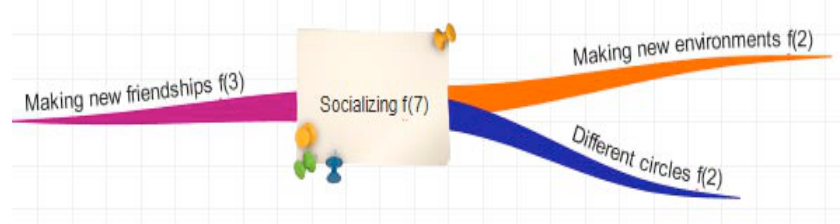
Figure 3. The category of